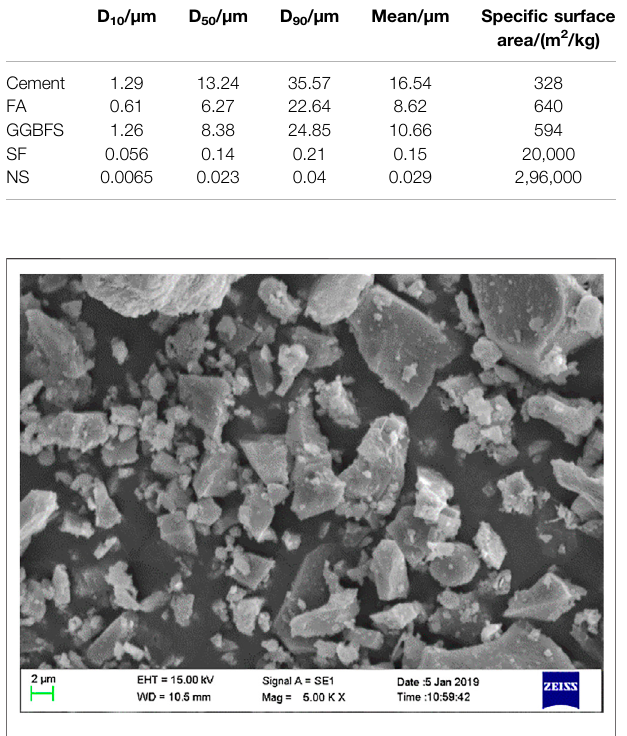
FIGURE 1 | SEM images of cement and SCMs, cement.